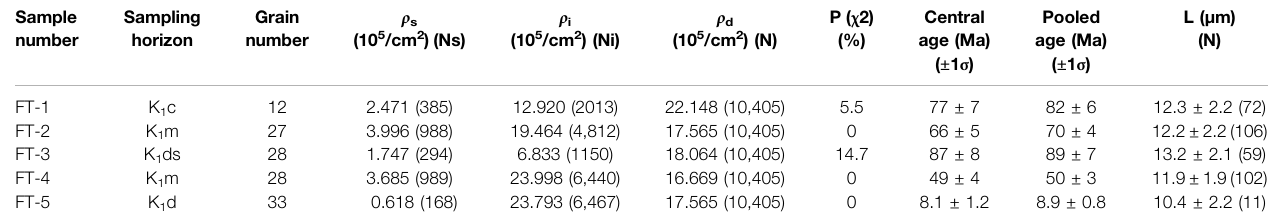
TABLE 2 | Fission track analysis results of samples. Sample Sampling number horizon